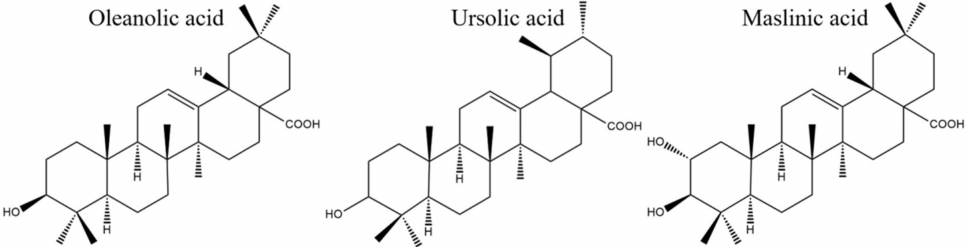
Figure 8. Structures of OA, UA, and